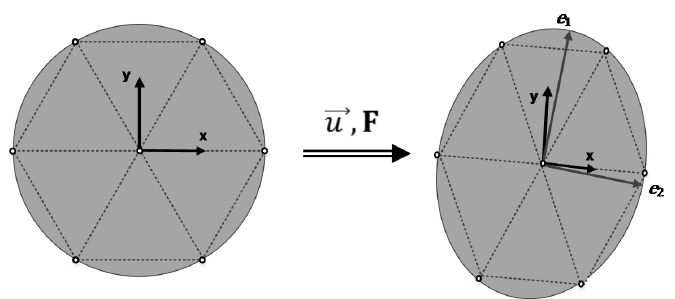
Figure 4. Major and minor strain definition, calculated using the eigenvectors (e1, e2) on deformation of the facet.